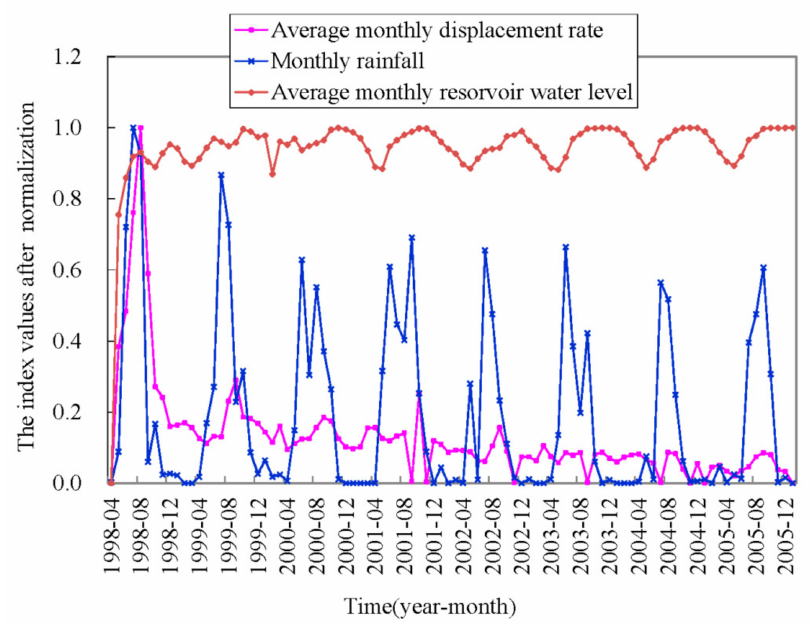
Figure 4. Relationship of the displacement rate of the landslide and its main influencing